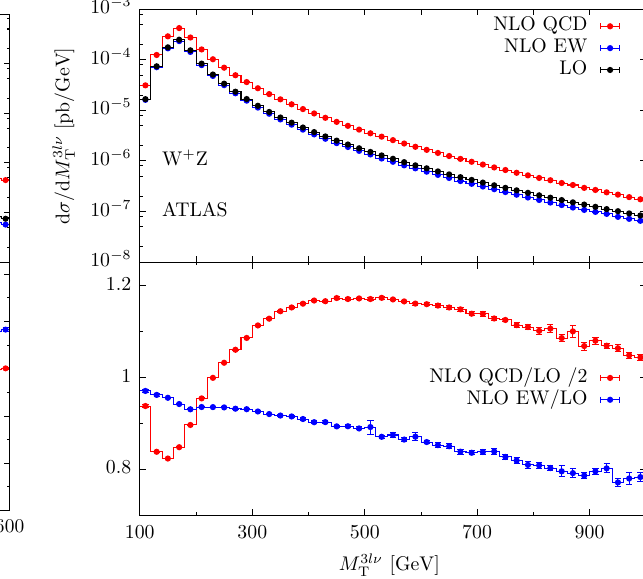
selections of Eqs. (4.8) and (4.7). The NLO QCD predictions have been ) divided by a factor 10 (2) in the ratio NLOQCD / LO as a function of √ T s = 13TeV under the event p T ,μ + μ − ( M 3 l ν ). Same notations and conventions as in Fig. 10 T